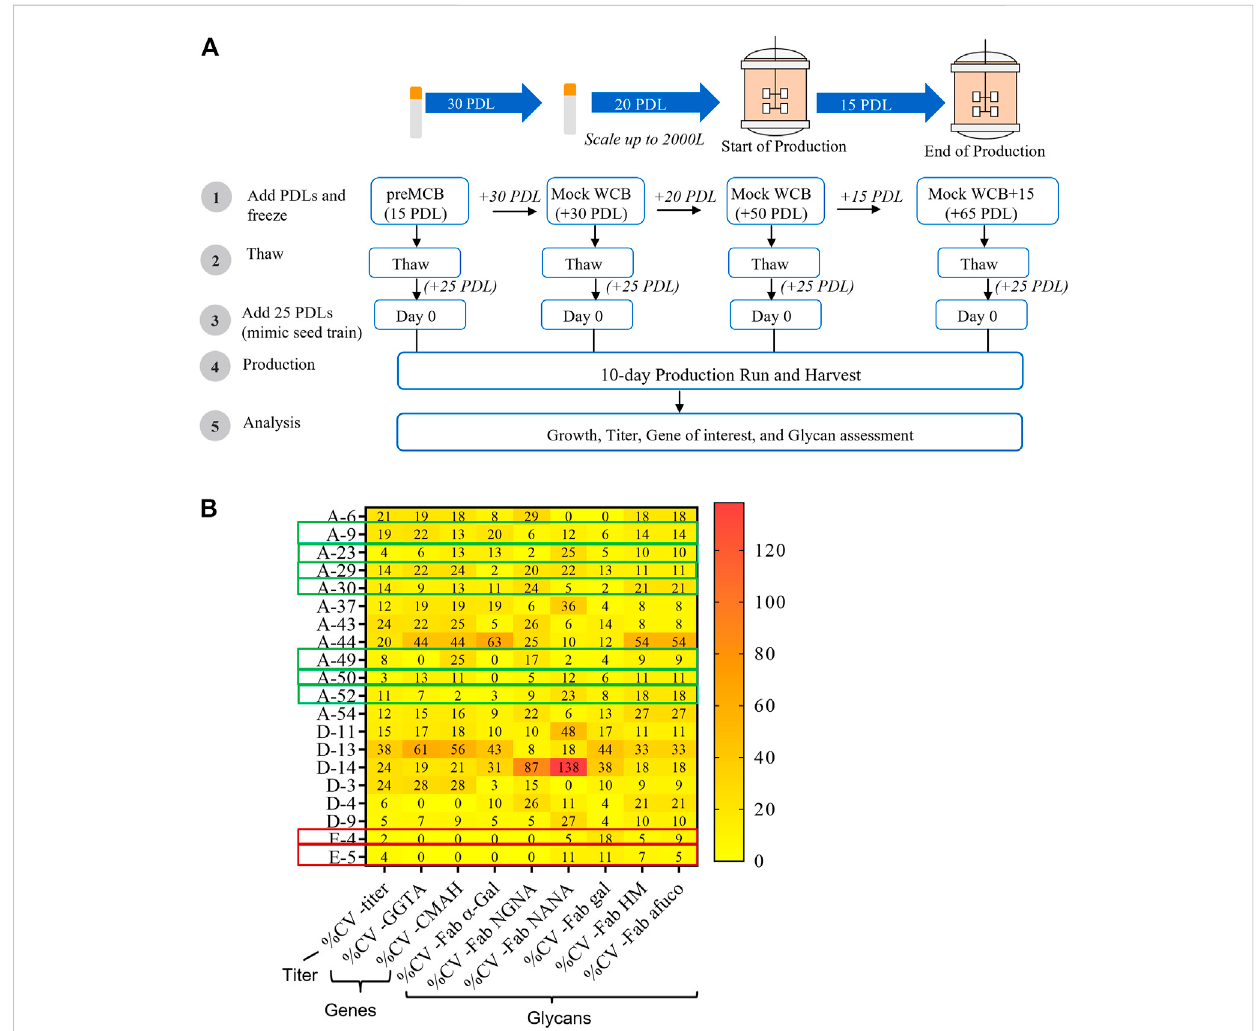
FIGURE 7 Impact of generational age cell line stability attributes. Cell line stability for 20 clones was assessed by evaluating changes in titer, mRNA expression of the genes of interest, and glycan pro fi le over de fi ned duration and intervals of Population Doubling Levels (PDLs). 20 clones included 18 clones from the CL1-A or CL1-D and two clones from the CL1-E control cell line. (A) Schematic of the stability study design. (B) The coef fi cient of variance (%CV) across different PDL for each clone was evaluated for productivity, mRNA expression of genes of interest, and glycans. Seven clones (from